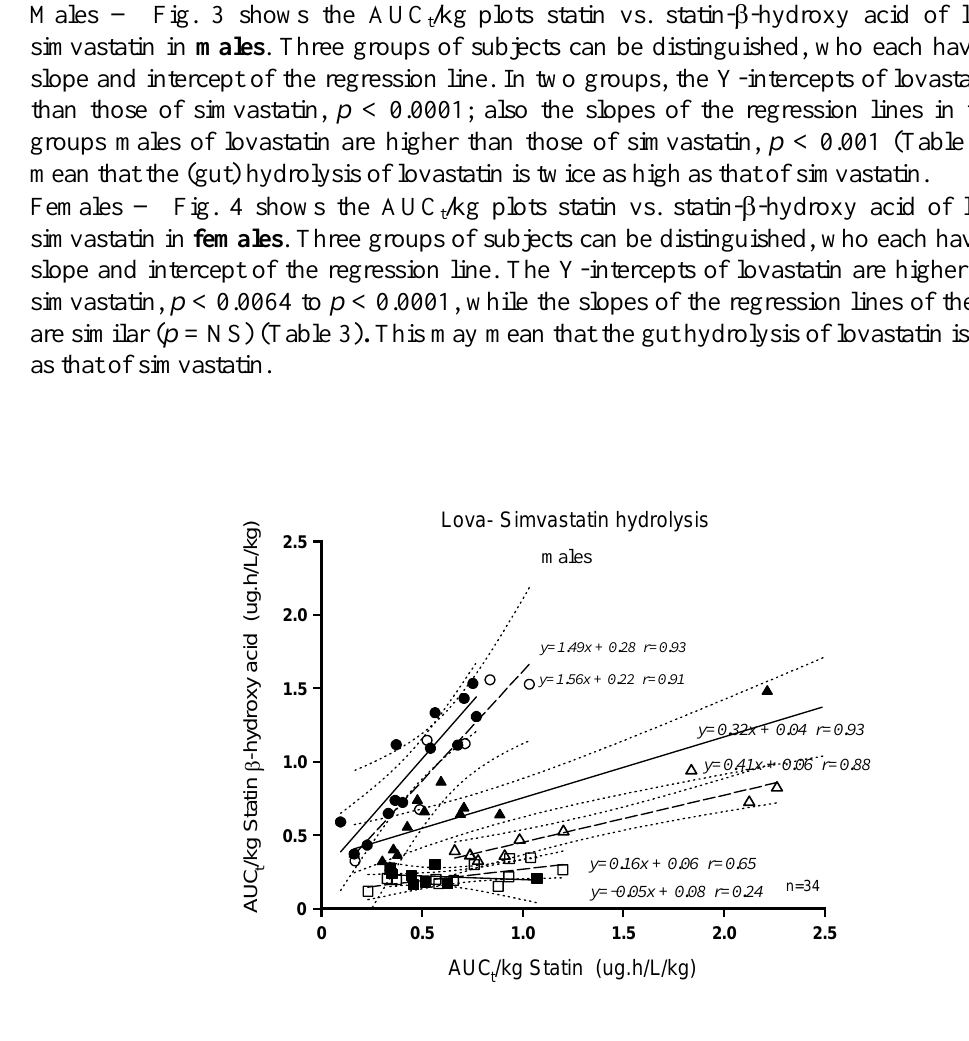
FIGURE 3. AUC t /kg of lovastatin (solid markers, solid line) and simvastatin (open markers, interrupted line) plotted vs. the corresponding AUC t /kg of the metabolite after an oral dose of 80 mg of the statin in male volunteers. Both statins show three groups of hydrolysis activities in both groups of male volunteers (parallel design). (Dotted lines are 95%